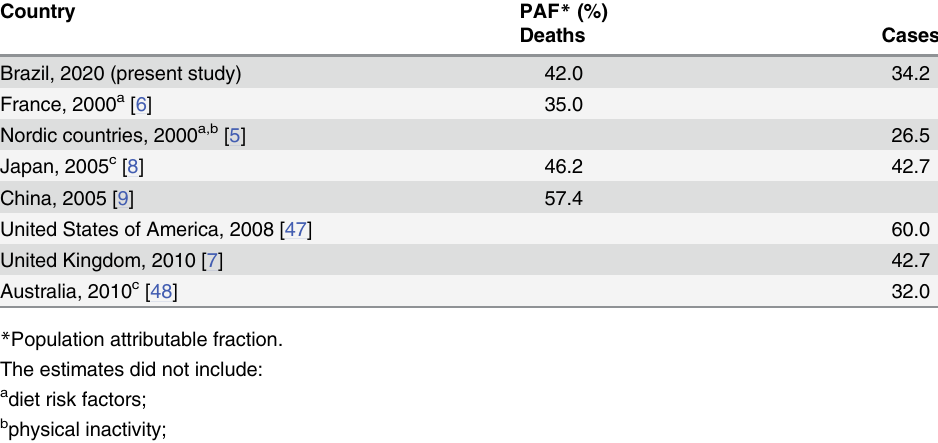
Table 3. Comparison of estimates of cancer deaths and incident cases attributable to the combined effects of modifiable risk factors among different countries.